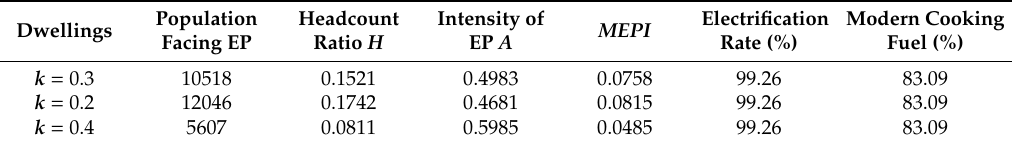
Table 5. Dwellings facing energy poverty with di ff erent deprivation limits.